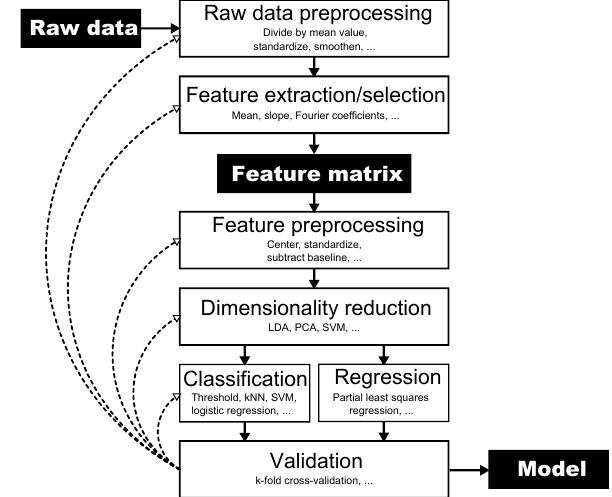
Figure 1. Flowchart of the steps involved in building a statistical model from raw data. The validation step is crucial to check the model’s performance. Any step and its parameters in the process in- fluence the model performance. However, the exact way is usually hard to predict, which results in a time-consuming trial-and-error process to find a model that performs well. Most available software packages for machine learning or statistical model building usually start at the feature matrix, thus ignoring the need for feature extrac- tion from the raw data, which is a crucial step, especially, but not only, for cyclic sensor